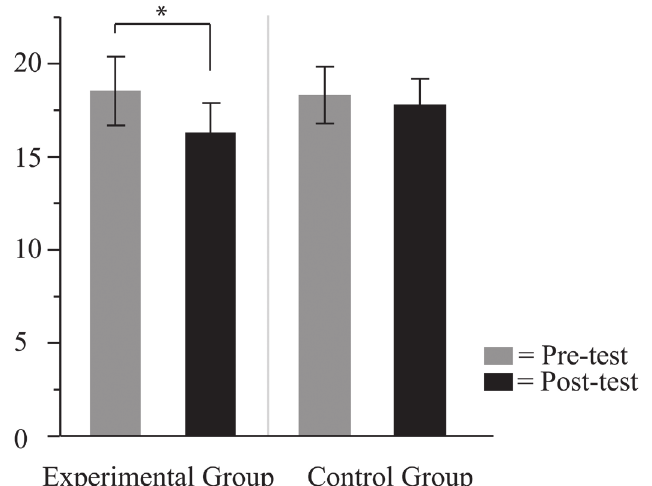
FIGURE 4. The average value of Beck Depression Inventory between experimental and control groups within pre- to